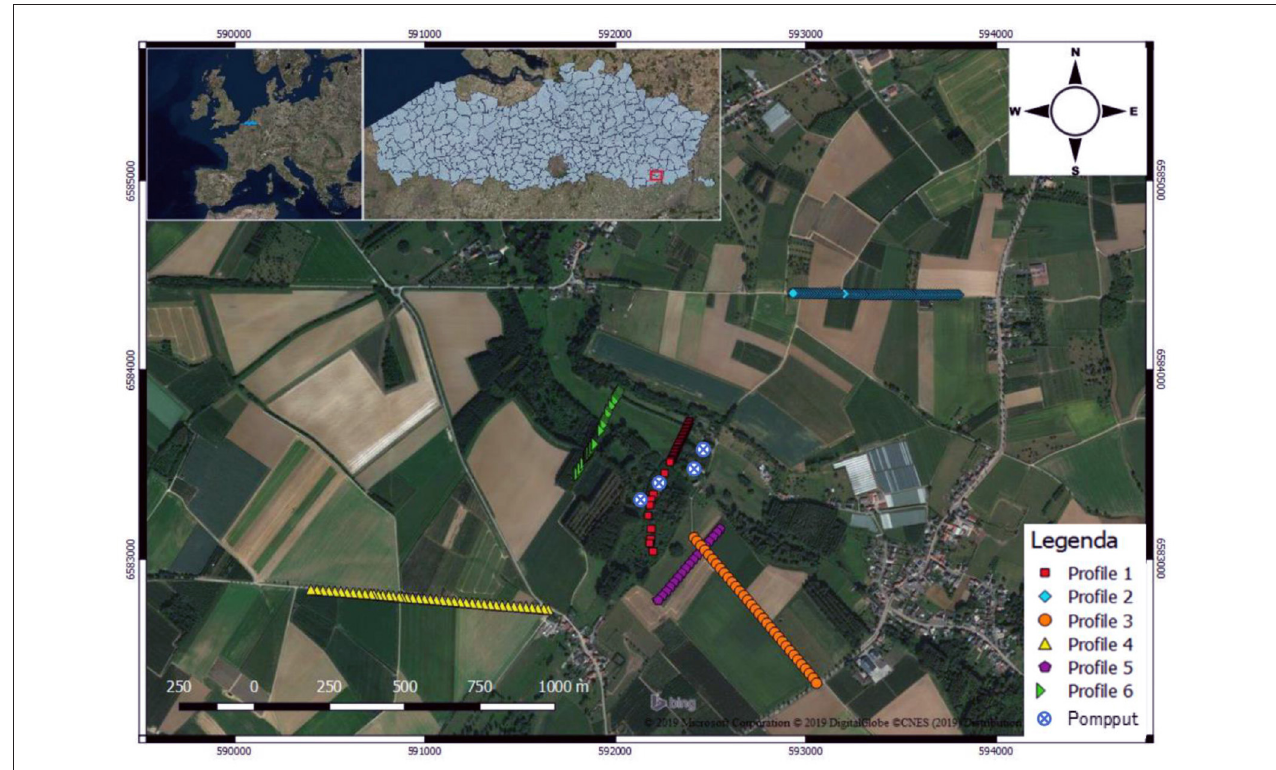
FIGURE 2 | Location of the ERT